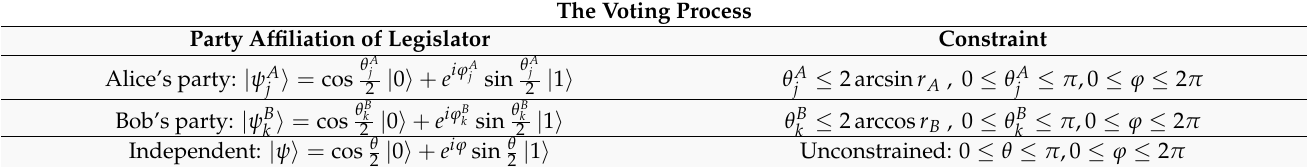
Table 1. This Table contains the constraints governing the vote of every representative, according to her party